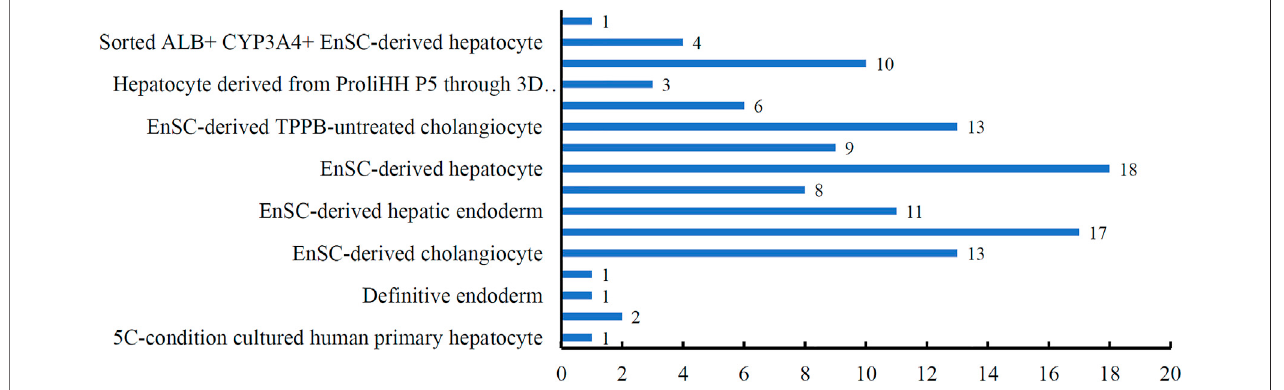
FIGURE 4 | Bar chart to show the number of rules for each cell type.